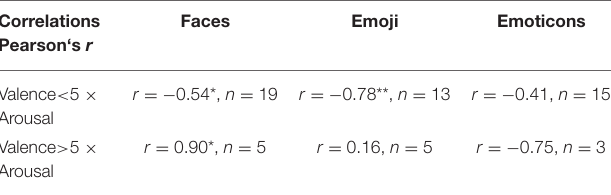
TABLE 3 | Correlations of valence and arousal for each stimulus category.